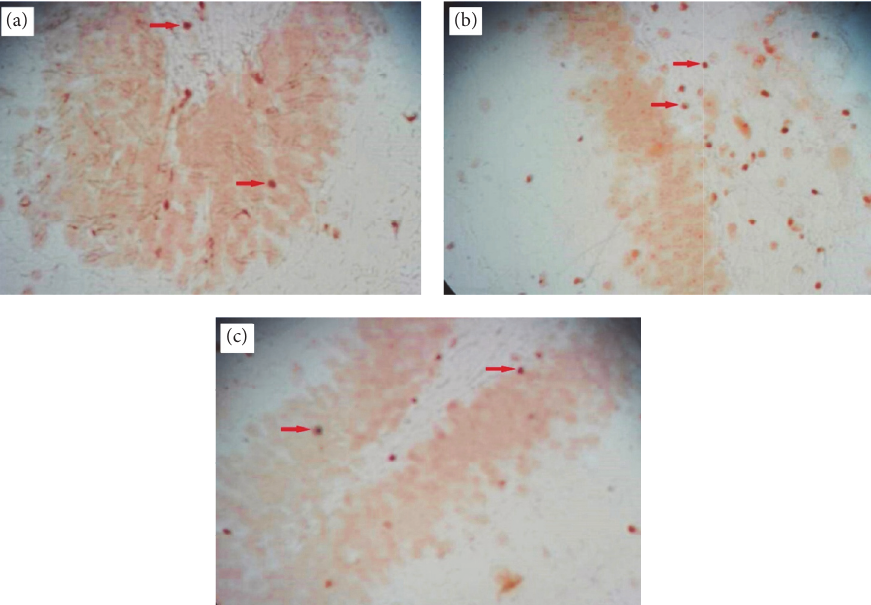
Figure 3: TUNEL reaction. (a) Control group with the lowest number of TUNEL positive (apoptotic) cells. (b) Ischemia group with the highest number of TUNEL positive (apoptotic) cells. (c) Treatment group with fewer TUNEL positive (apoptotic) cells compared to the ischemia group. The arrows show TUNEL positive cells (brown).